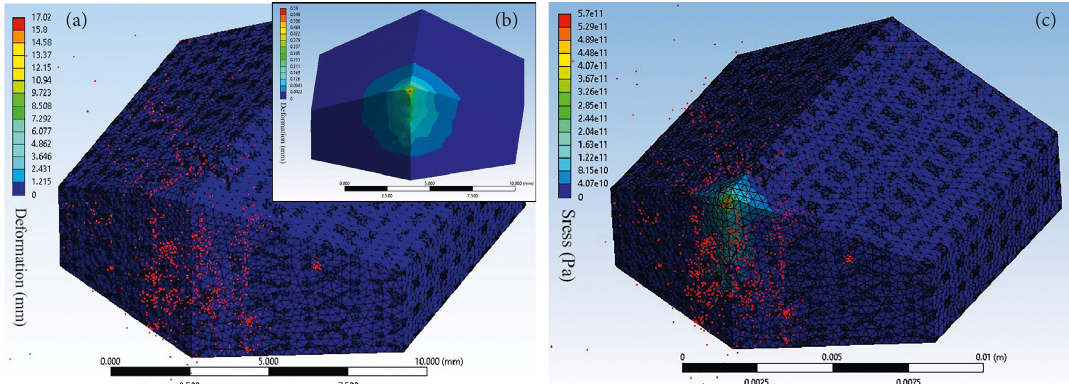
Figure 15: Deformation (a, b) and Von Mises stress distribution (c) of insert made of diamond with lattice. Red points of images (a) and (c) illustrate the fine particles of metal lattice that are relocated from the original position. Image B shows deformation of the material with excluded relocated particles.